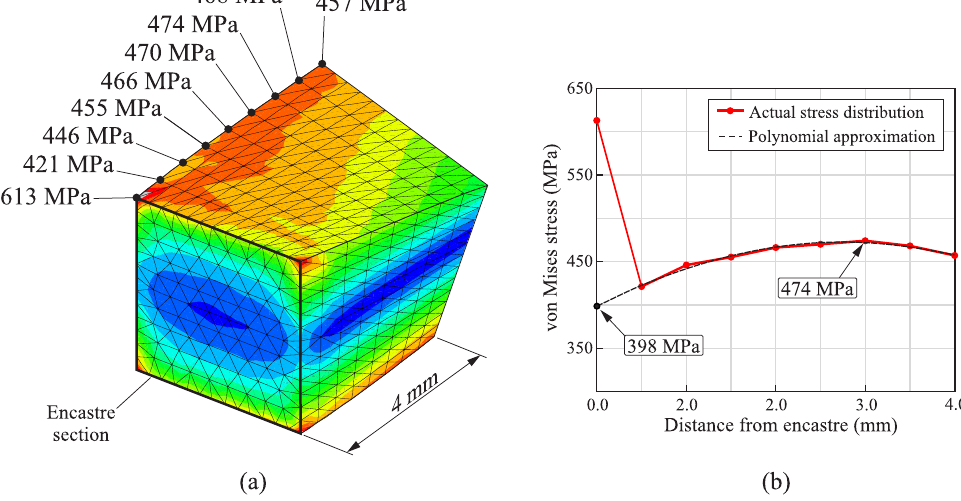
Figure 10. Stress results for bending analysis: ( a ) detail of the region where maximum von Mises stress takes place and ( b ) evolution of the von Mises stresses along the